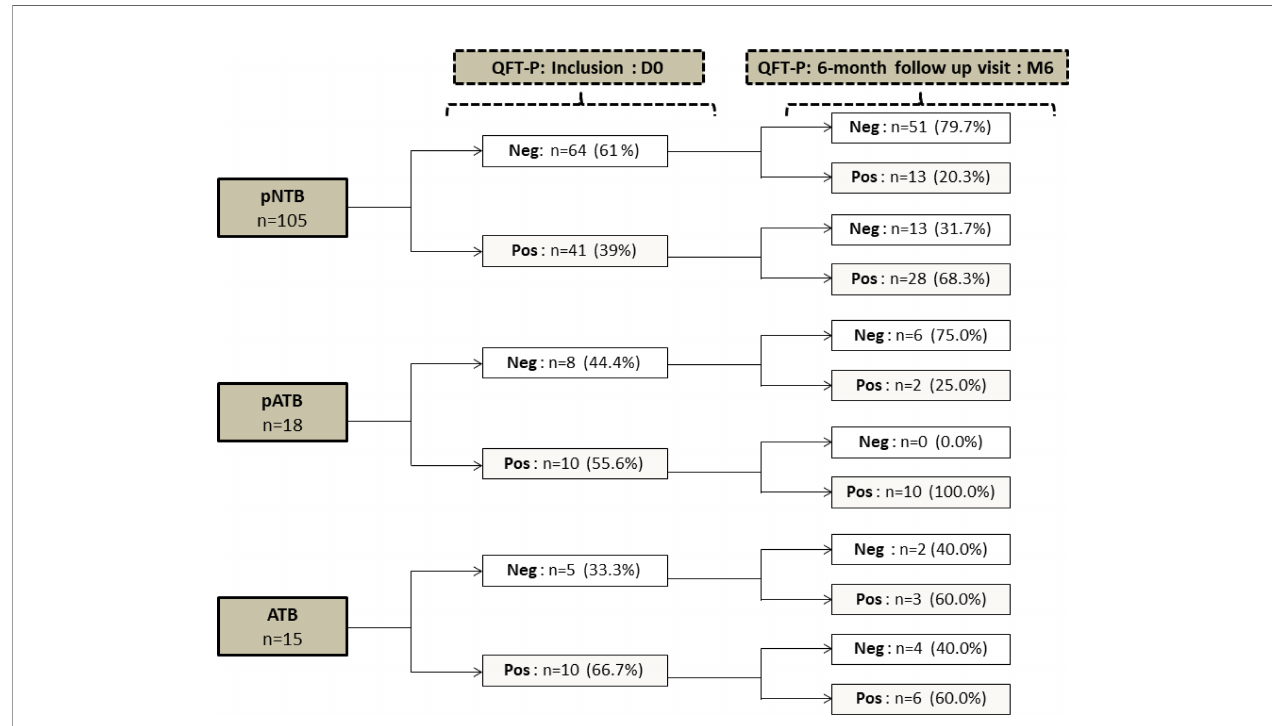
FIGURE 3 | Qualitative QuantiFERON-TB Gold-Plus Assay conversion and reversion proportion within pregnant women (pNTB and pATB) and TB-con fi rmed non- pregnant women (ATB) groups between inclusion (D0) and the 6-month follow-up visit (M6). QFT-P, QuantiFERON-TB Gold Plus; Neg, negative; Pos, positive; DO, inclusion; M6, six months follow up visit; pNTB, non-TB pregnant women; pATB, TB-con fi rmed pregnant women; ATB, TB-con fi rmed non-pregnant